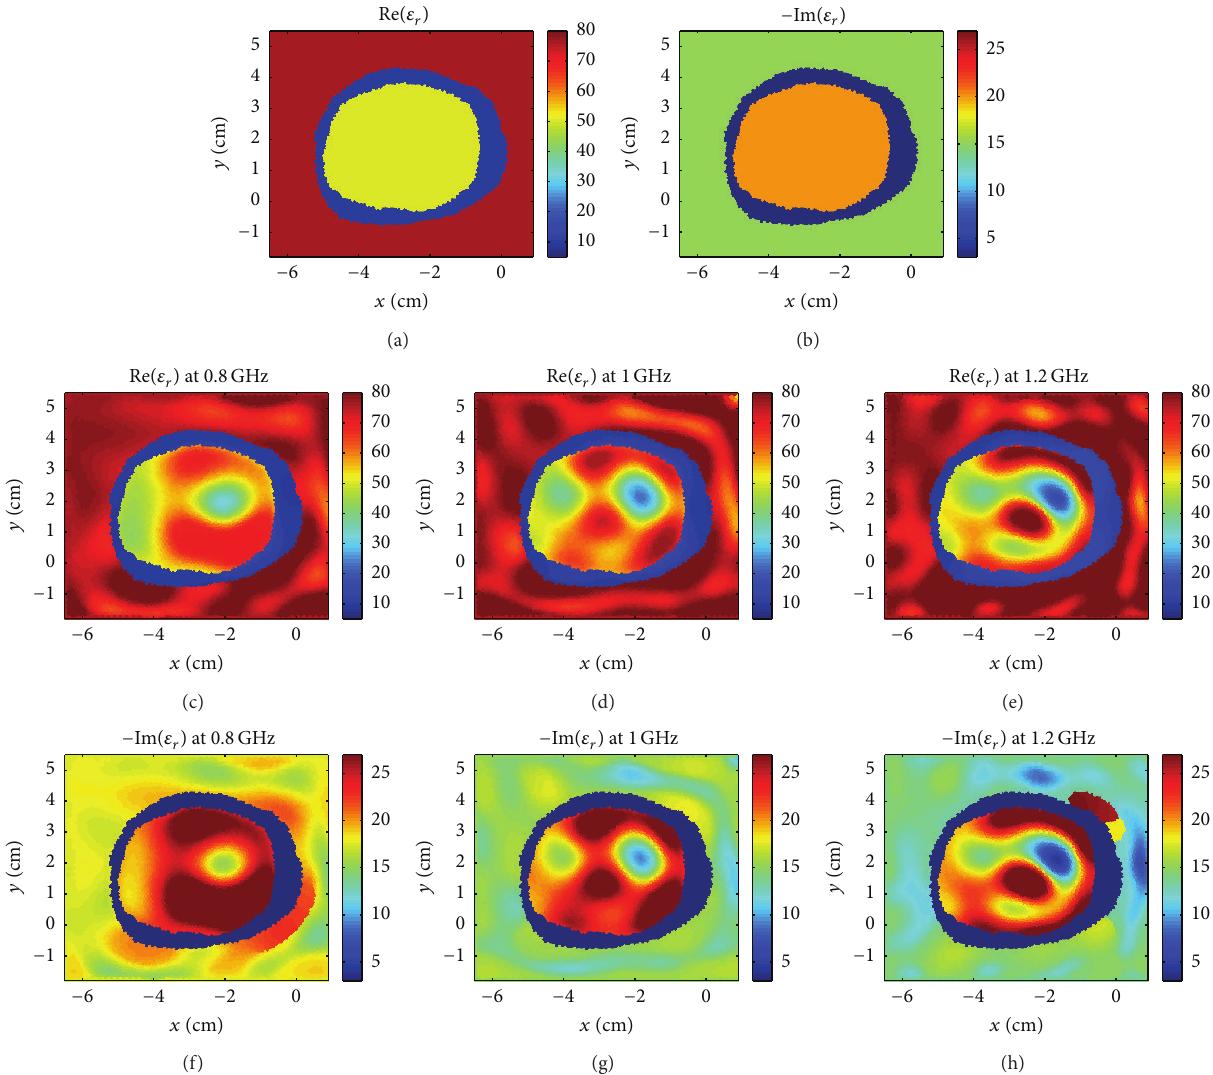
Figure 12: Volunteer 3: (a)-(b) prior information. The reconstruction when prior information is used as inhomogeneous background at (c), (f) 0.8 GHz, (d), (g) 1GHz, and (e), (h)